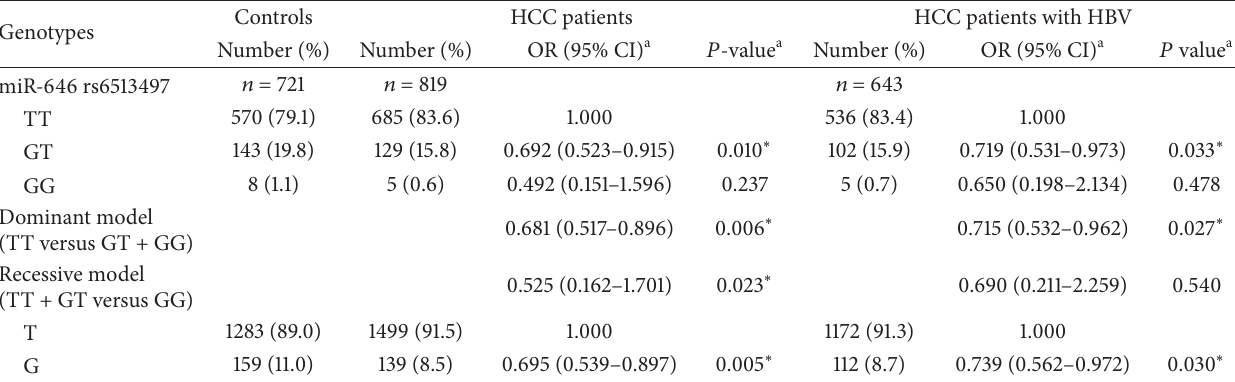
Table 3: Comparison of genotype/allele frequencies of miR-646 rs6513497 in male subjects.